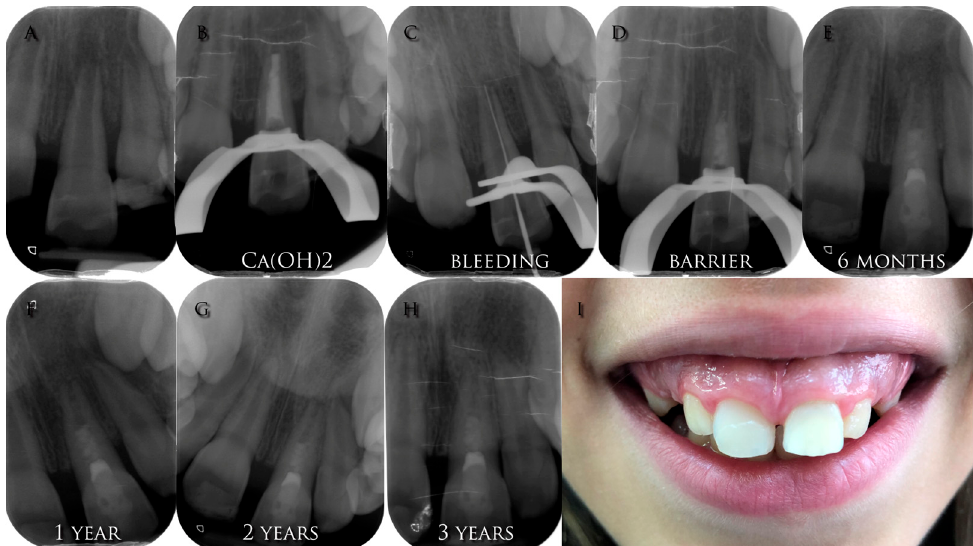
Figure 3. ( A ) Pre-operative radiograph of a young necrotic upper left central incisor with open